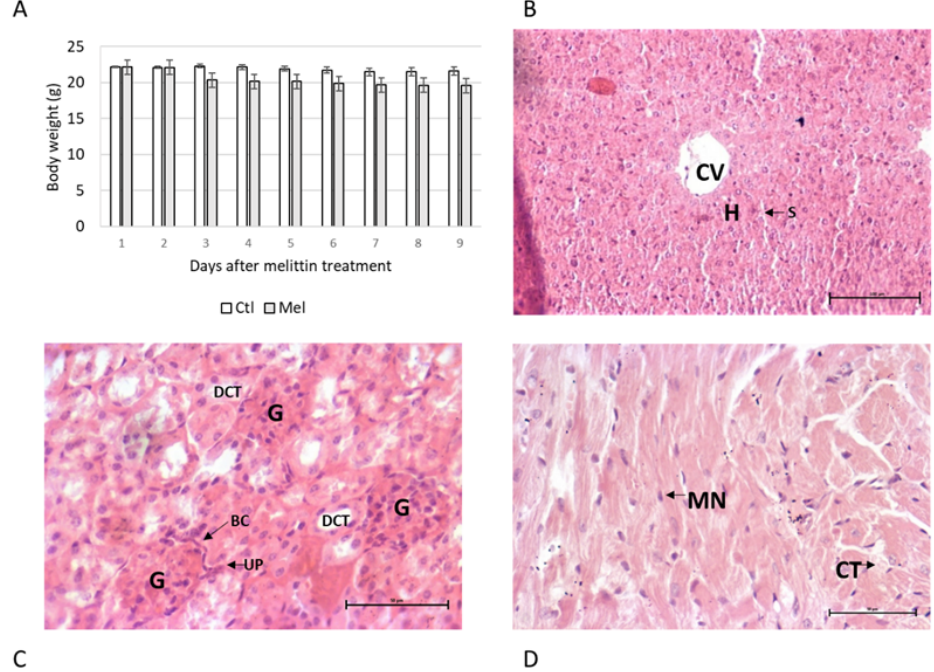
Figure 5. Body weight and histological structure of leaver, kidney and heart following seven days after a single dose of melittin treatment (day 27) showing absence of structural toxicity of melittin. (A) Graph showing normalized animal body weight (mean ± SD) over time after the day of melittin injection (day 19) in untreated or melittin-treated animals; weight loss is observed in animals treated with melittin (p < 0.01). Note the stabilization of body weight 24 h after melittin injection. (B) Liver micrograph of melittin group showing normal histological structure of the central vein (CV) and surrounding hepatocytes (H) and sinusoids. (C) Kidney micrograph of melittin group showing normal histological structure of the glomerulus (G), Bowman’s capsule (BC), urinary polo (UP) and distal convoluted tubule (DCT). (D) Cardiac muscle micrograph showing normal histological structure of the striated cardiac muscle, single central nucleus (MN) for each cell and connective tissue (CT) between muscle cells. Untreated animals (n = 3); melittin-treated animals (n = 6). H&E, B [200×], C and D